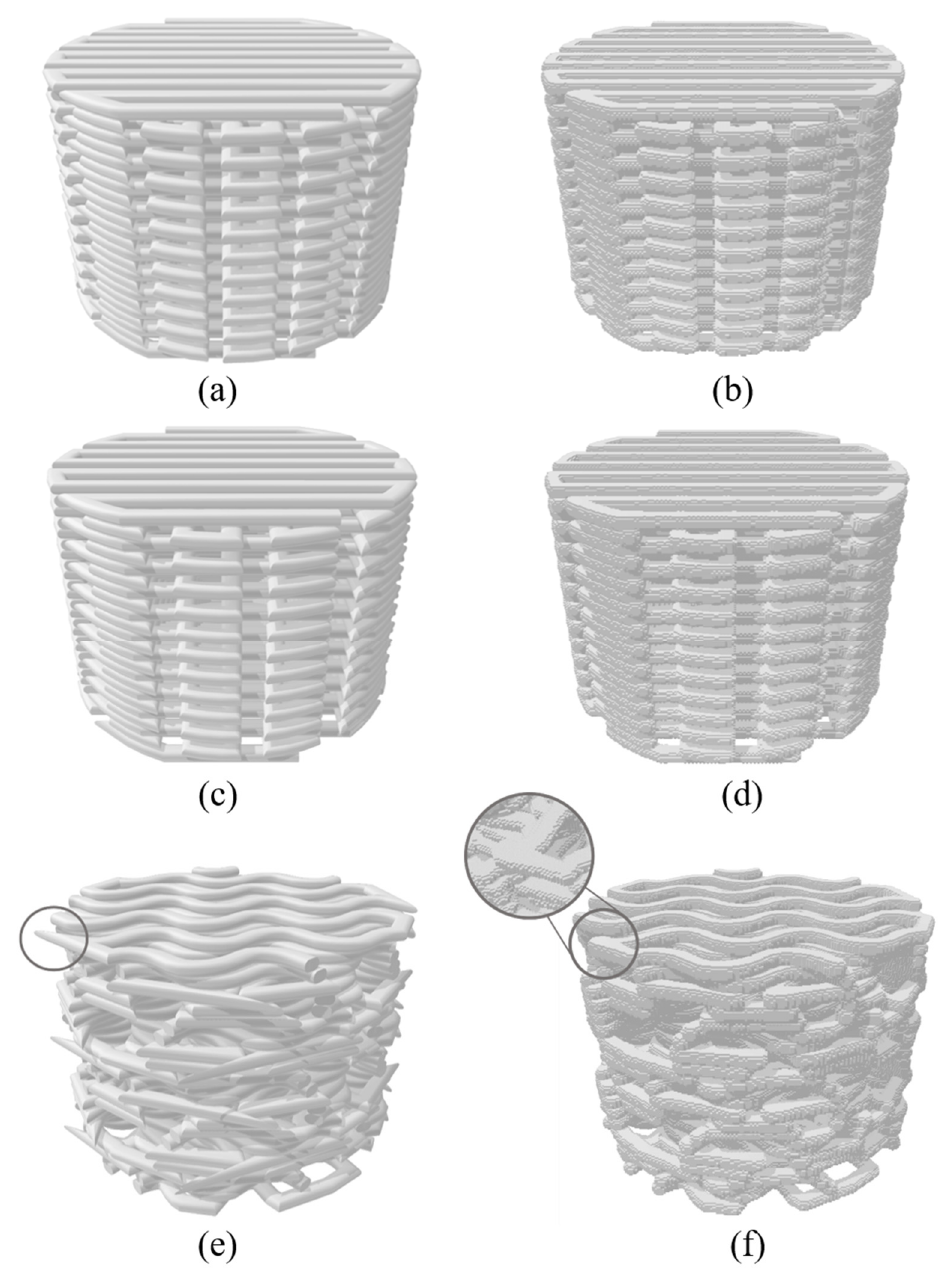
Figure 12. Models: ( a ) 50_rect DECODE ( b ) 50_rect VOLCO, ( c ) 60_rect DECODE, ( d ) 60_rect VOLCO, ( e ) 50_gyr DECODE and ( f ) and 50_gyr VOLCO.